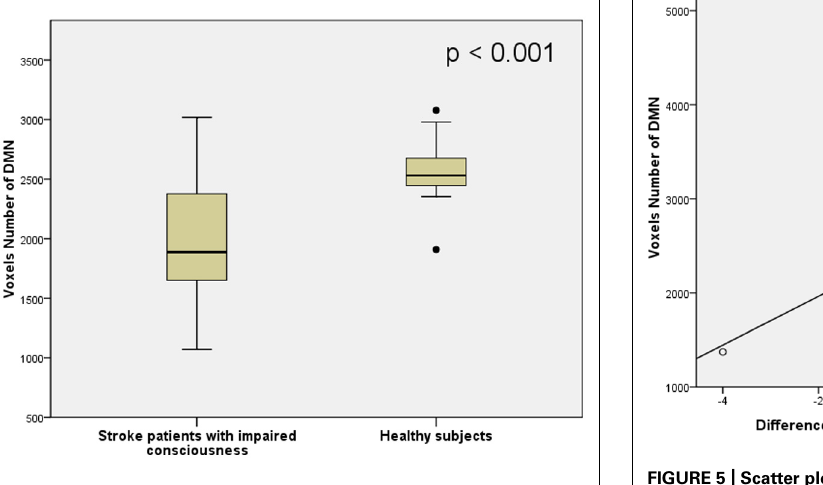
FIGURE 5 | Scatter plot correlation between voxel number inside the DMN and the difference between Glasgow Coma Scale (GCS) scores at the time of discharge and at the time of MRI